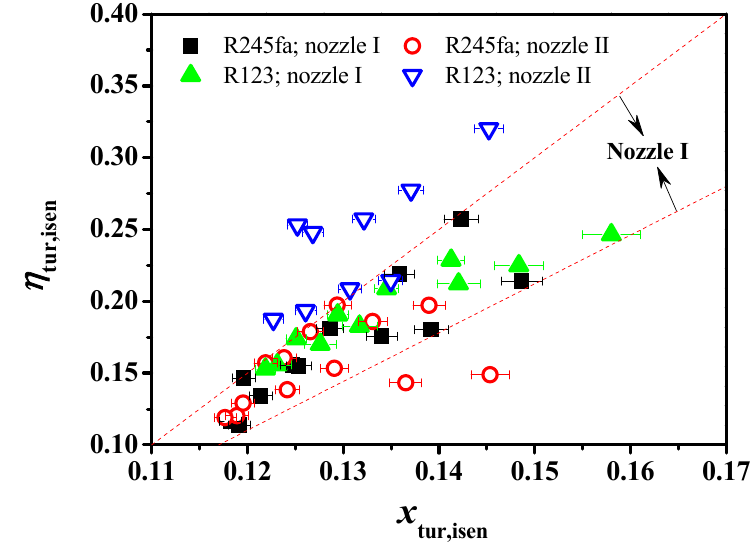
Figure 13. Variation of turbine isentropic efficiency with isentropic velocity ratio.